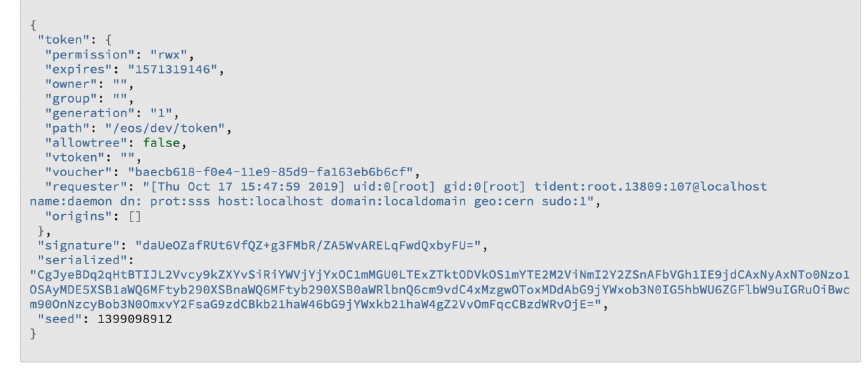
Figure 5. JSON representation of an EOS